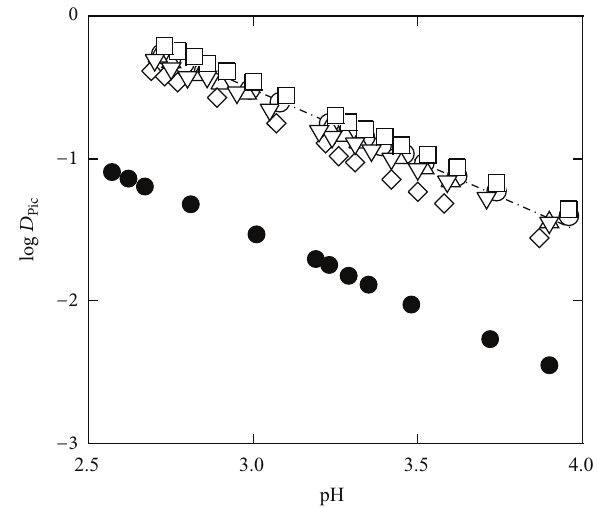
Figure 1: Plots of log 𝐷 versus pH for six diluents. Circle: DCE; Pic triangle: DCM; full circle: CBu; diamond: BBz; inverted triangle: Bz; square: mX. A broken line is the regression one for the DCE system = 2.489 –pH–log (1+3.86×10 − pH ) at 𝑅 = 0.998 basedon(2):log 𝐷 Pic